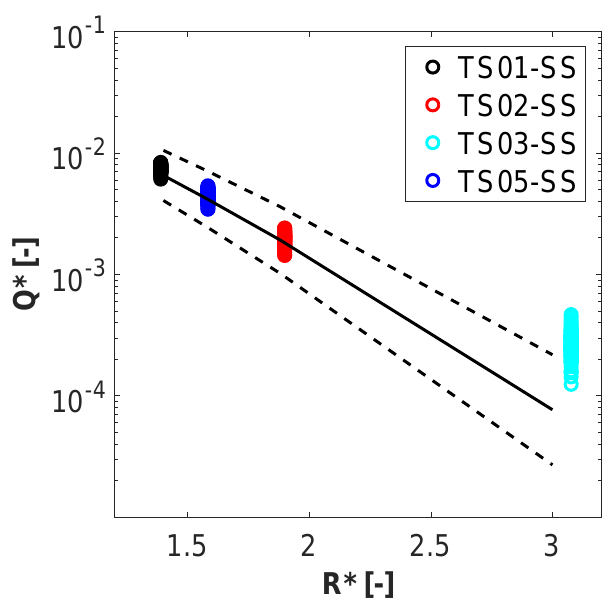
Figure 6. Graph showing R ∗ plotted against Q ∗ for random seeding test with smooth slope structure. Solid line: Empirical prediction. Dashed line: Confidence